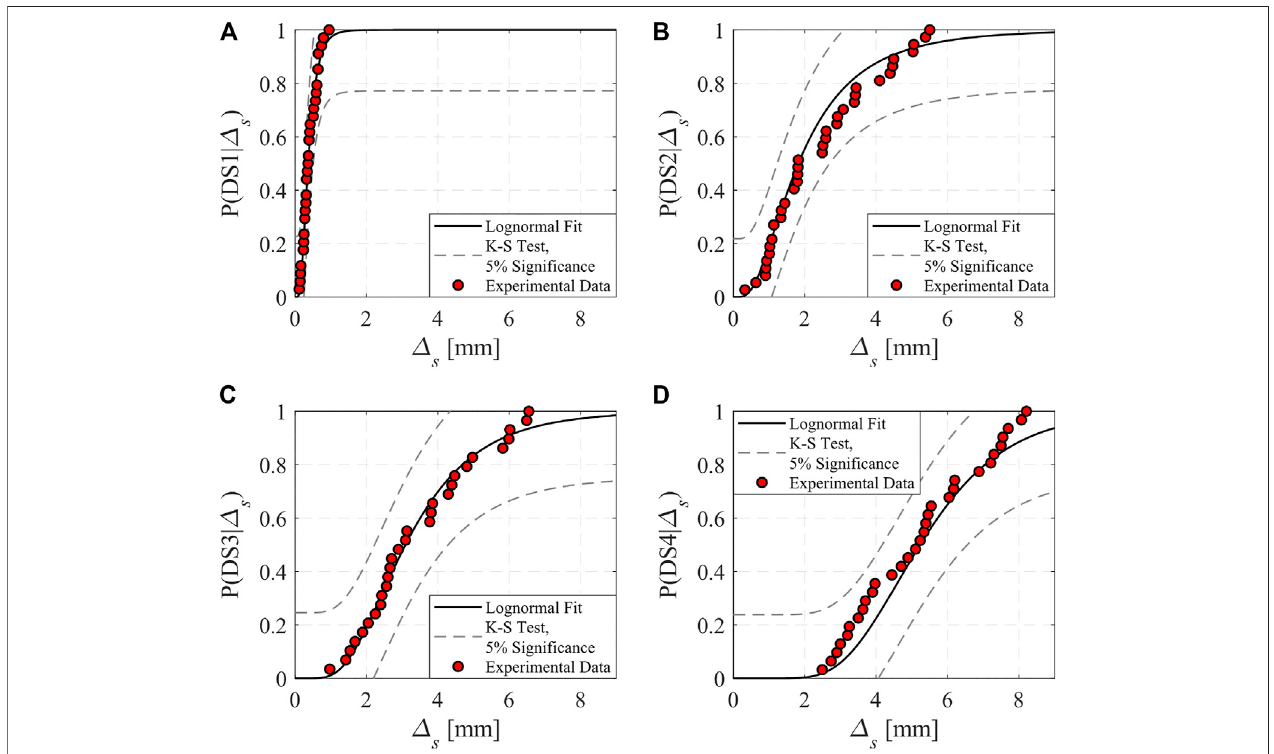
FIGURE 5 | Slip-based fragility functions corresponding to the four damage states in steel beam-slab connections. (A) DS1 (B) DS2 (C) DS3 and (D) DS4.